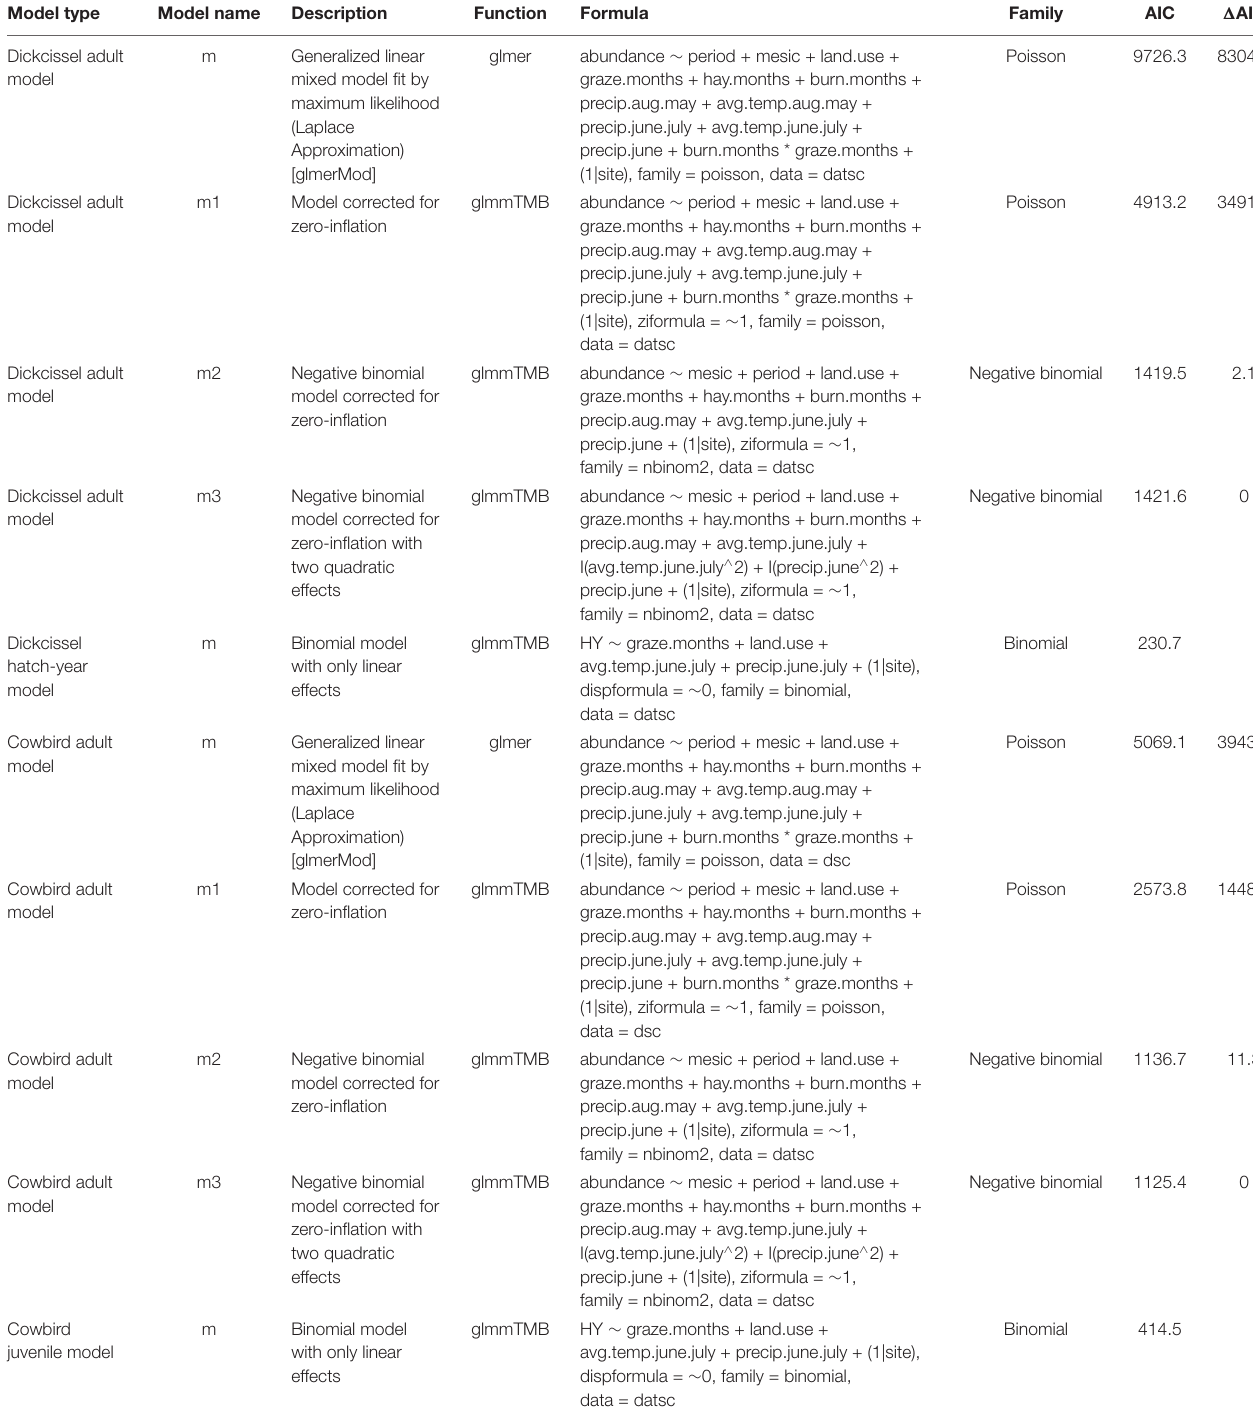
TABLE 4 | AIC table for all